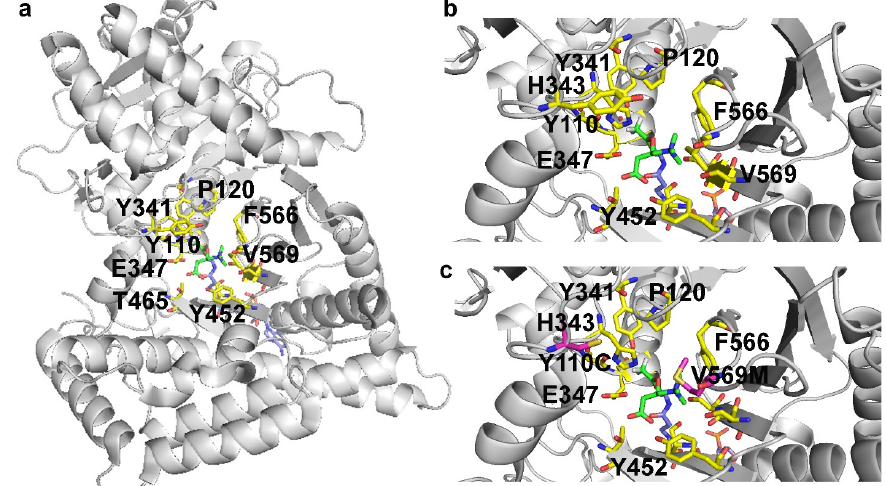
Figure 5. The side view of the CRAT enzyme is reported in grey cartoon representation. ( a ) Residues within 4 Å from carnitine (green sticks) are reported in yellow sticks. Acetyl-CoA is reported in blue sticks. The exploded views of the CRAT wild type and of the double mutant (Y110C/V69M) are reported in panel ( b ) and panel ( c ), respectively. The missense mutations Y110C and V569M are reported in magenta sticks in panel ( c ).